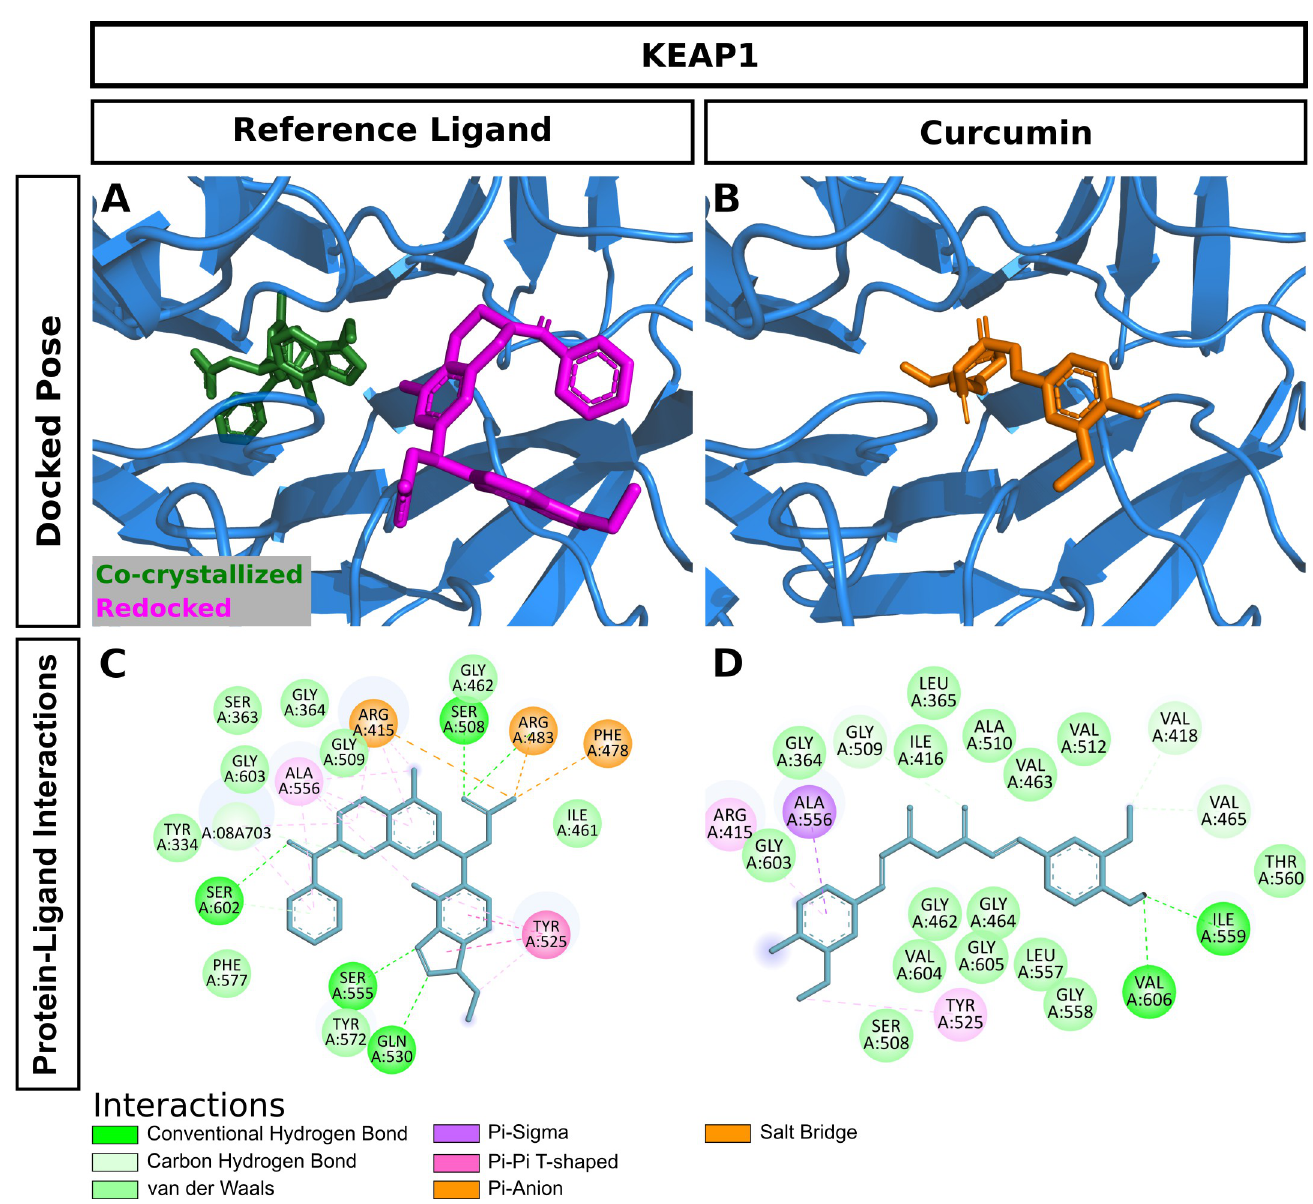
Fig 9. Molecular docking of curcumin to KEAP1. (A) Redocking of the bound ligand. (B) Docking pose of curcumin. (C) Interactions of the bound ligand with the protein. (D) Predicted interactions of curcumin with the protein. a very high probability score (0.83) (Fig 11). Vina docking showed a higher binding affinity (Table 2) and comparable binding interactions of curcumin (Fig 12B and 12D) and the bound ligand harmine (Fig 12A and 12C) for MAOA, supporting the SwissTargetPrediction results. For BACE1, the estimated binding energies were -8.5 and -10 for curcumin and SCH734723, respectively (Table 2). In this case, Vina redocking perfectly matched the docking pose of SCH734723 in the BACE1 crystal structure (Fig 13A). Curcumin was also predicted to dock at the same binding pocket (Fig 13B). Intriguingly, multiple similar amino acid residues of BACE1 are likely to interact with both the reference ligand and curcumin (Fig 13C and 13D).